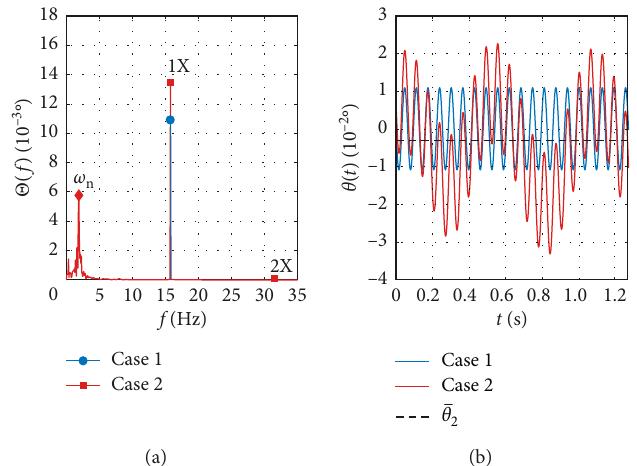
Figure 10: Comparison of the angular displacement of vibrating screen: (a) frequency spectrum and (b)